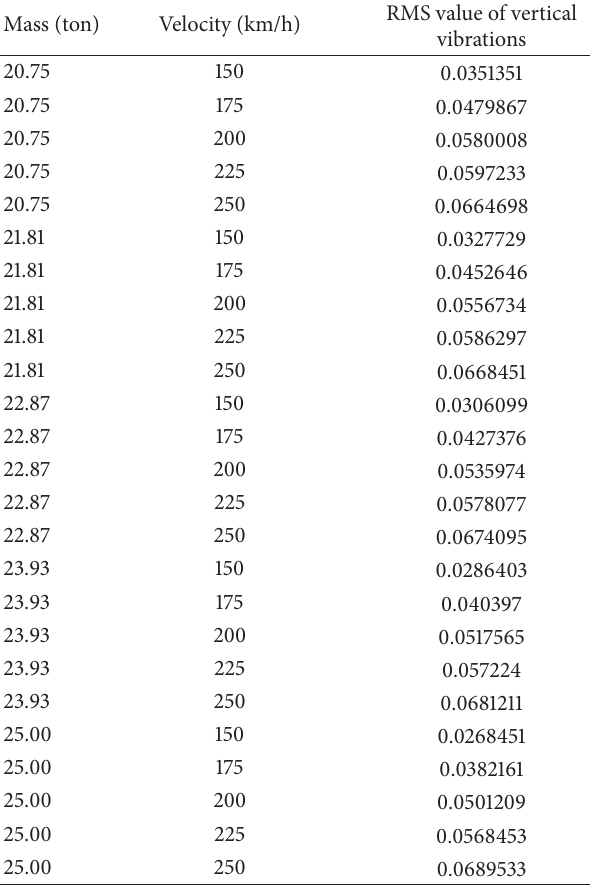
Table 5: DOE of Taguchi and result of numerical